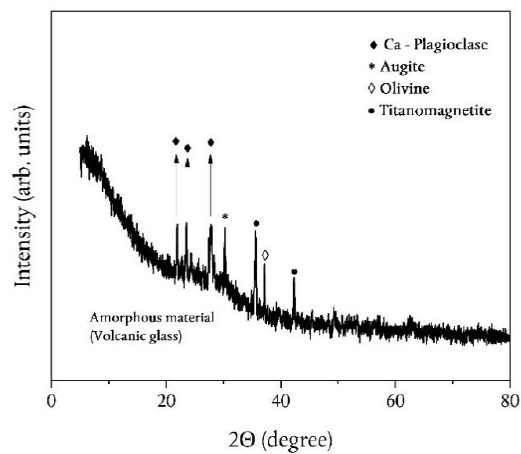
Figure 8. A representative XRD pattern of the sampled pyroclastic products.